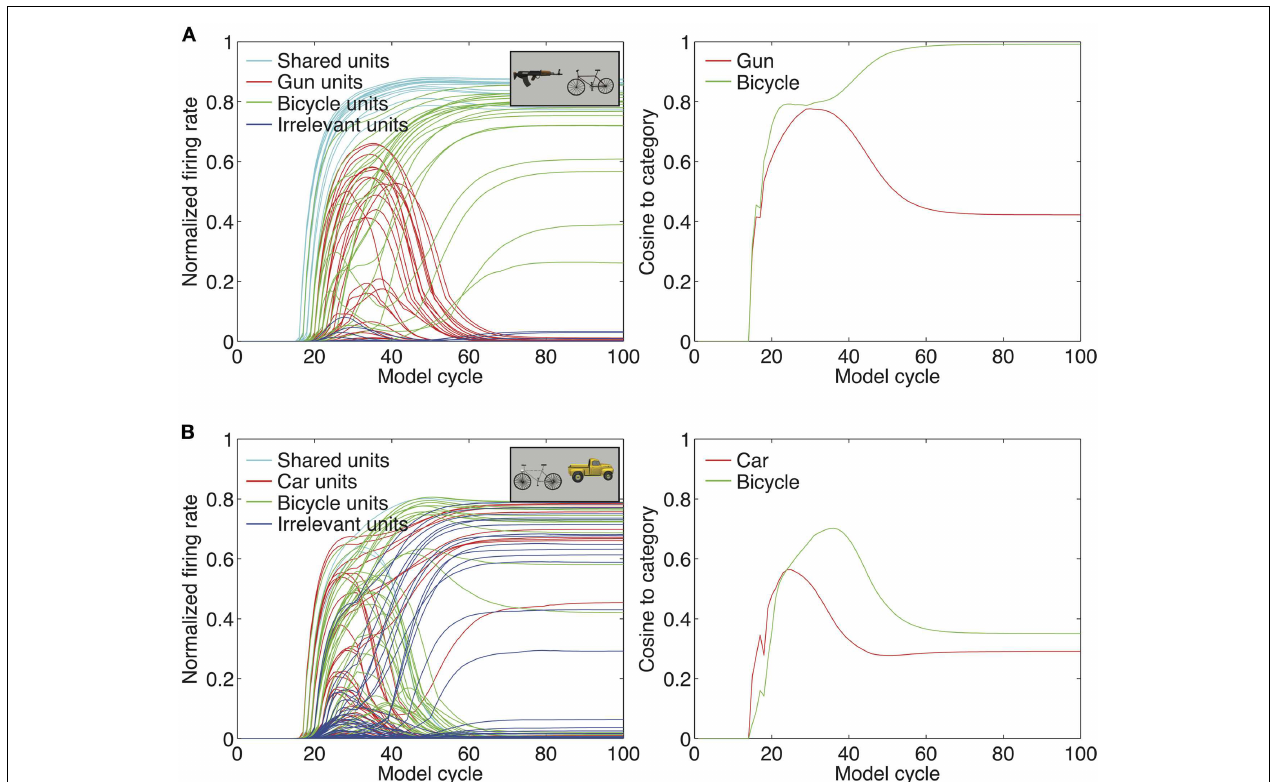
responses from completely irrelevant units.Top-down feedback serves to reinforce units from the winning object that may not have been initially active. (B) Binding errors occur when completely irrelevant units become erroneously active, leading to the inability to suppress invalid responses.This creates illusory conjunctions of features across the objects in the display, leading to a representation that does not resemble either category.